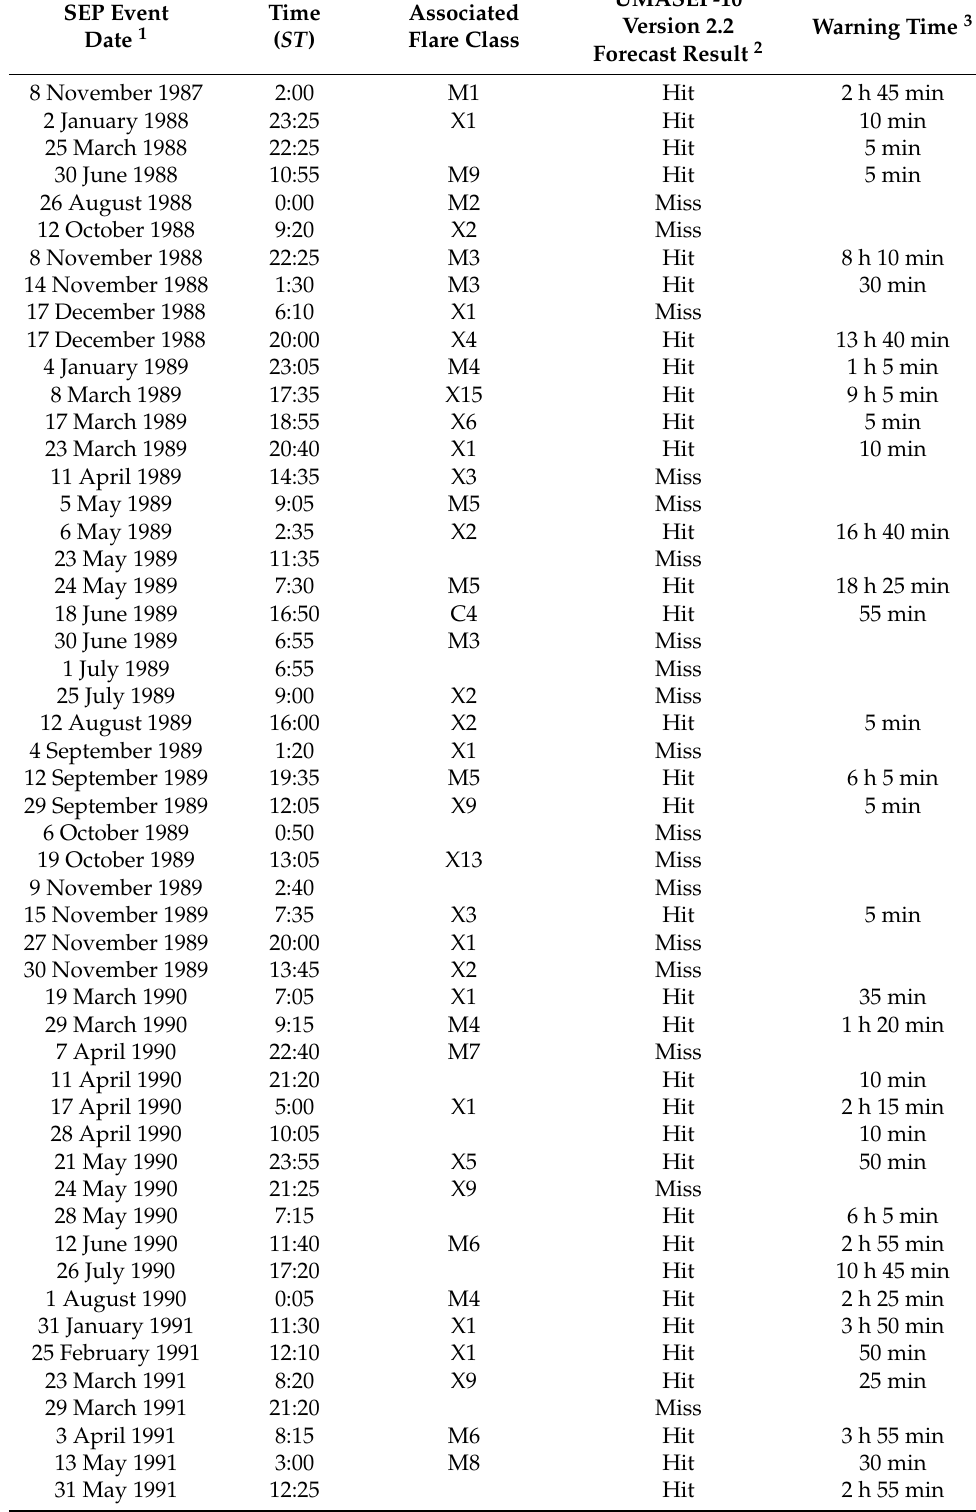
Table 1. Forecast results of UMASEP-10 version 2.2 (the most recent version of this tool) for each event of solar cycles 22–24 using the SWPC threshold on the GOES satellite data. Start times of SEP events of solar cycles 23 and 24 are presented according to Bain et al. [2]. The events of solar cycle 22 are extracted from the SWPC SEP event list in https://umbra.nascom.nasa.gov/SEP (accessed